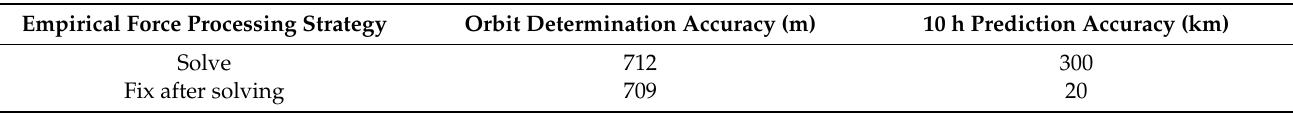
Table 7. Analysis of orbit determination and prediction accuracy.